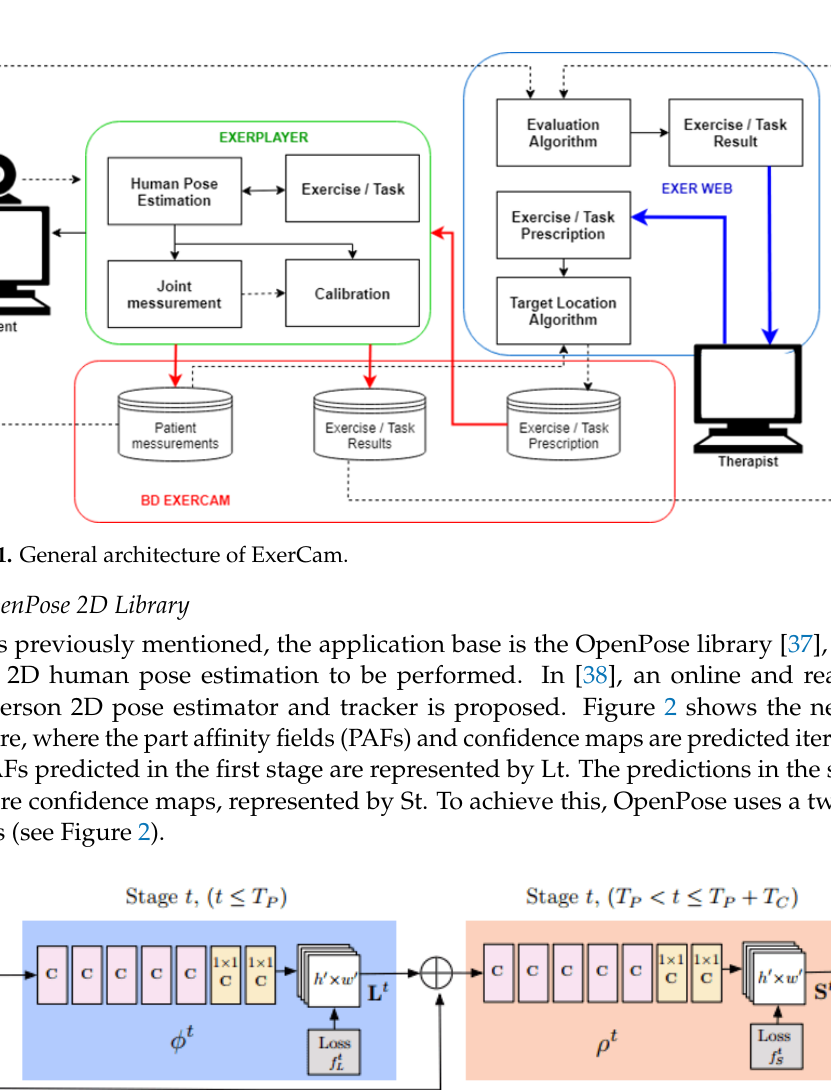
Figure 2. Architecture of the multistage CNN from the 2018 version of OpenPose [37]. 166